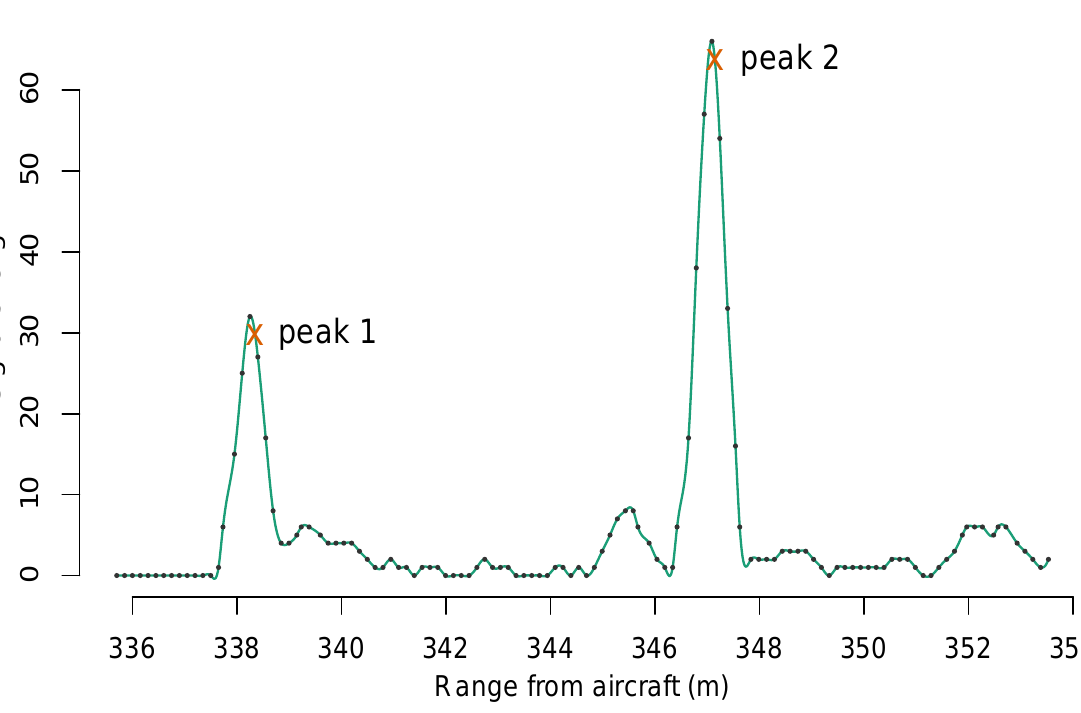
Figure 1. An example waveform and probable associated discrete return points. The 120 waveform samples are shown as circles and a spline fit to these data appears as a solid line. A peak detector might detect two peaks at about 338 and 347 meters and return the intensity value when the peak is detected as shown with exes. Without knowledge of future sample values, real time peak detection algorithms usually produce a slight lag in peak